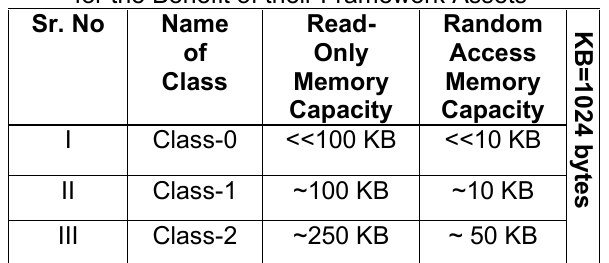
Table 1 clears up the projected request of IoT devices dependent on their open resources. Class-0 (C0) is a lot of resources forced so that they have the least various talents to assist secure correspondence over the framework. Class-1